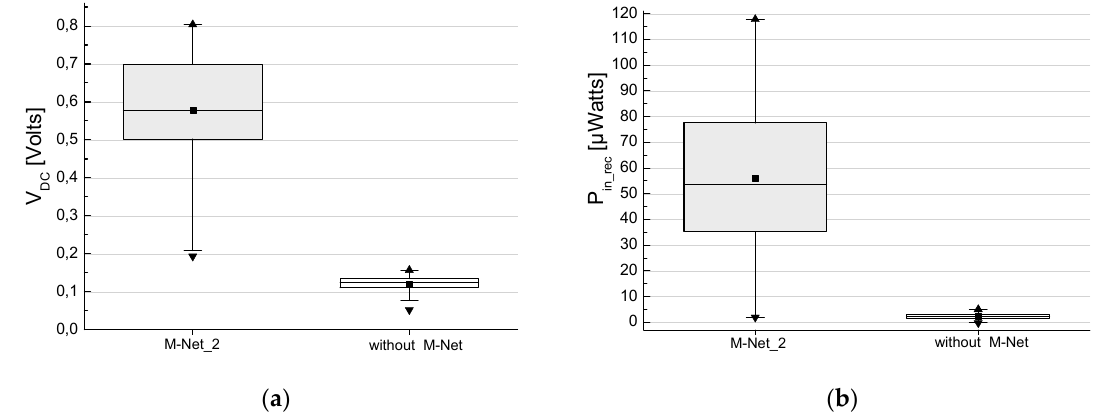
Figure 18. With M-Net_2: statistical results over frequencies in the matching bands, the DoAs and both rectifiers for ( a ) V DC ( b ) P in_rec.